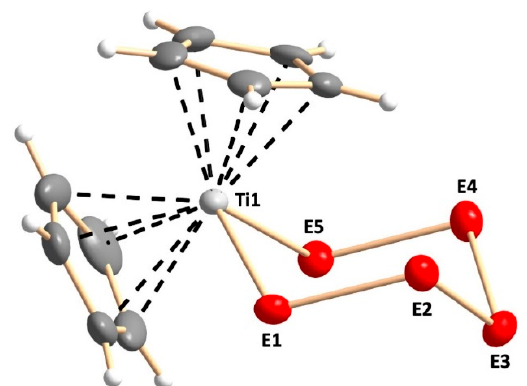
Figure 2. Molecular structure of [TiCp 2 Se x S 5 − x ] as exemplified by Phase C . In phases B – E the chalcogen atom positions marked with “E i ” ( i = 1–5) are disordered with sulfur and selenium in random positions. The site occupancy factors are shown in Table S1 in the Supporting Information. The anisotropic displacement parameters are shown at 50% probability level.